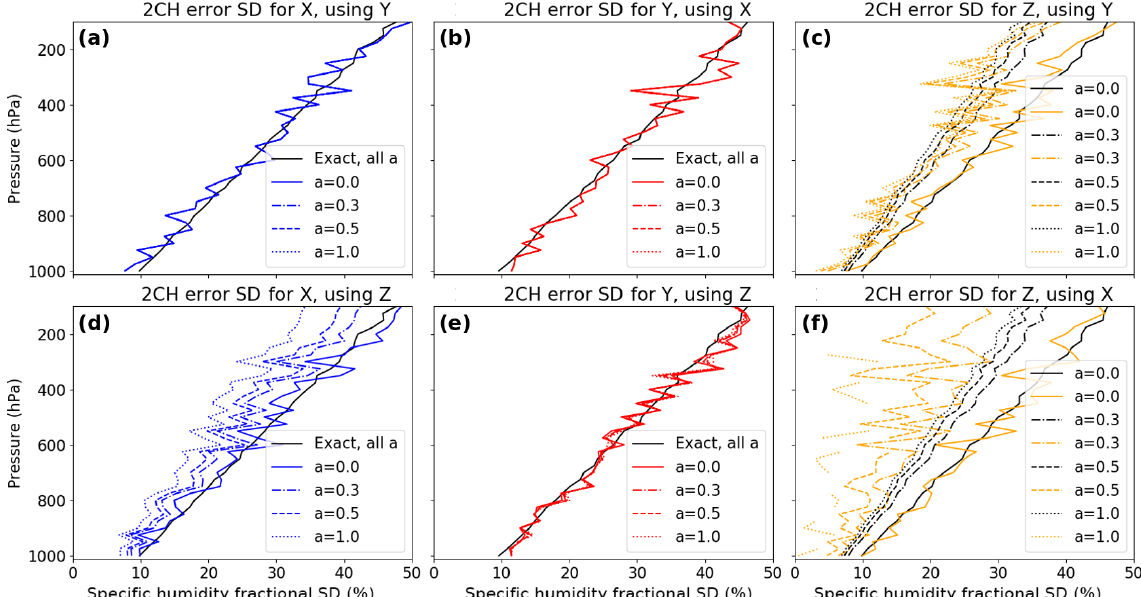
Figure 7. Two 2CH results each for the normalized error SD for X (a, d) , Y (b, e) and Z (c, f) , depending on the second data set. Profiles corresponding to several values of correlation parameter a are included. The solid black profile is the exact error SD profile for X and Y for all values of a , and for Z when a = 0.